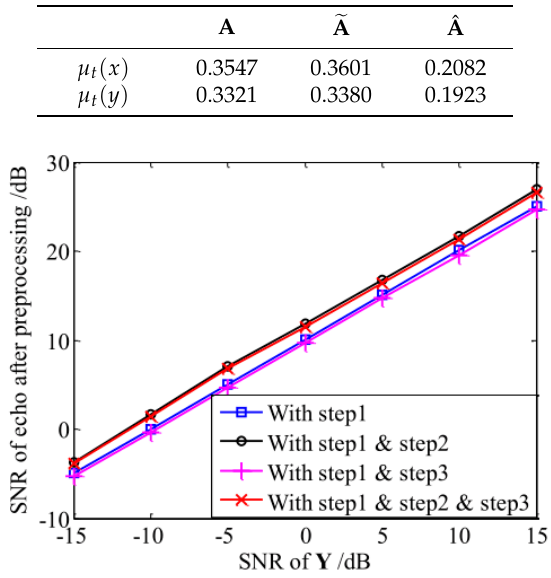
Figure 1. The SNR after applying different preprocessing methods to the original echo.